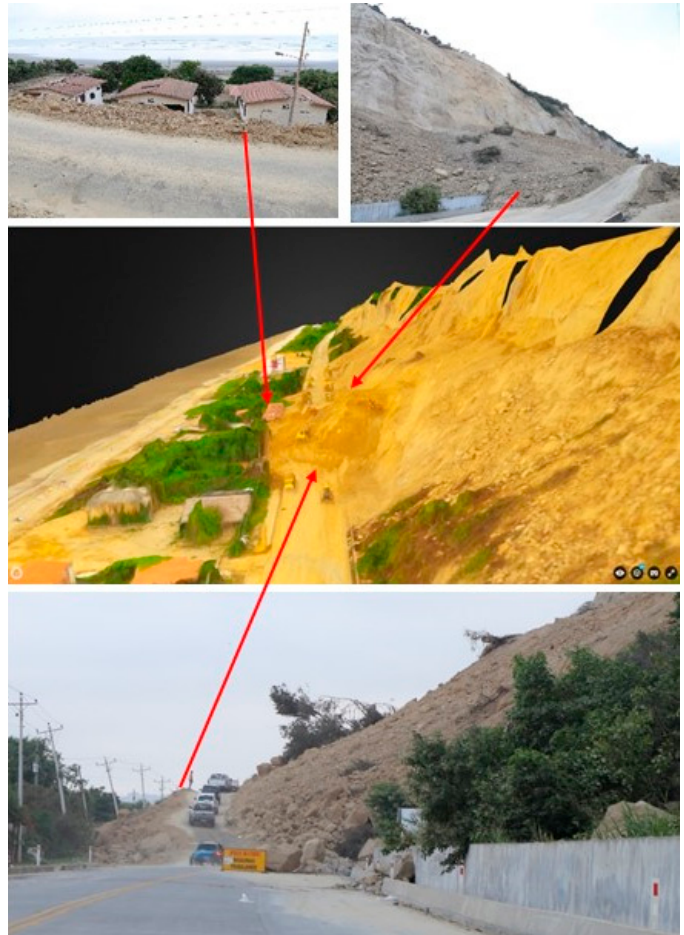
Figure 5. Example of disrupted landslide at Briceño: rock fall and debris displacement, fractured slopes, completely destroyed road, house damaged by landslide, volume ca 10.000 m 3 (VIII ESI-07 ); courtesy of drone imagery by Global Medic and Servicio Nacional de Gestión de Riesgo y Emergencias de Ecuador; locations on Figure 2.